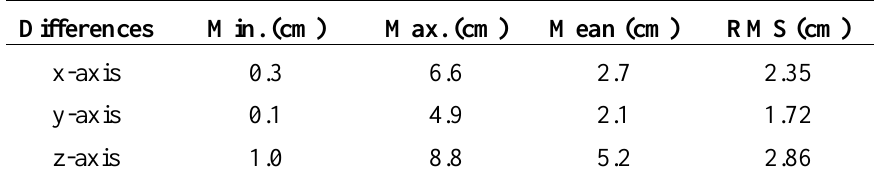
Table 5 . Analysis of differences between the static and RTK GPS